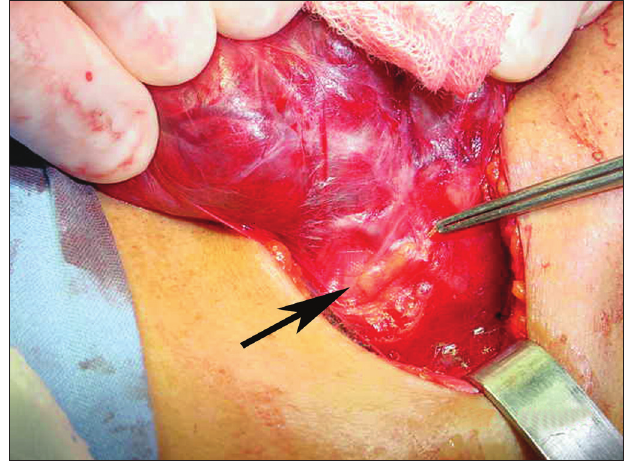
Figura 1. Identificação extracapsular de glândula tireoide no campo operatório.